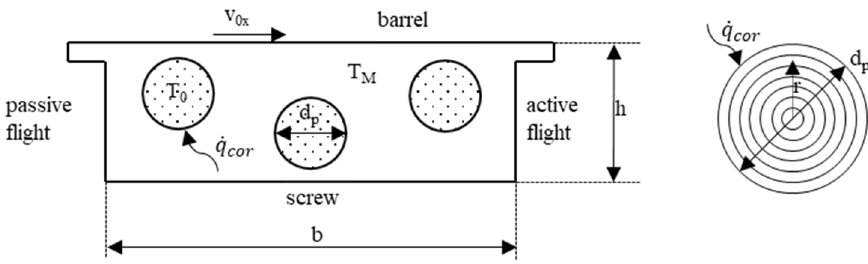
Figure 5. Schematic representation of disperse melting with calculation variables.